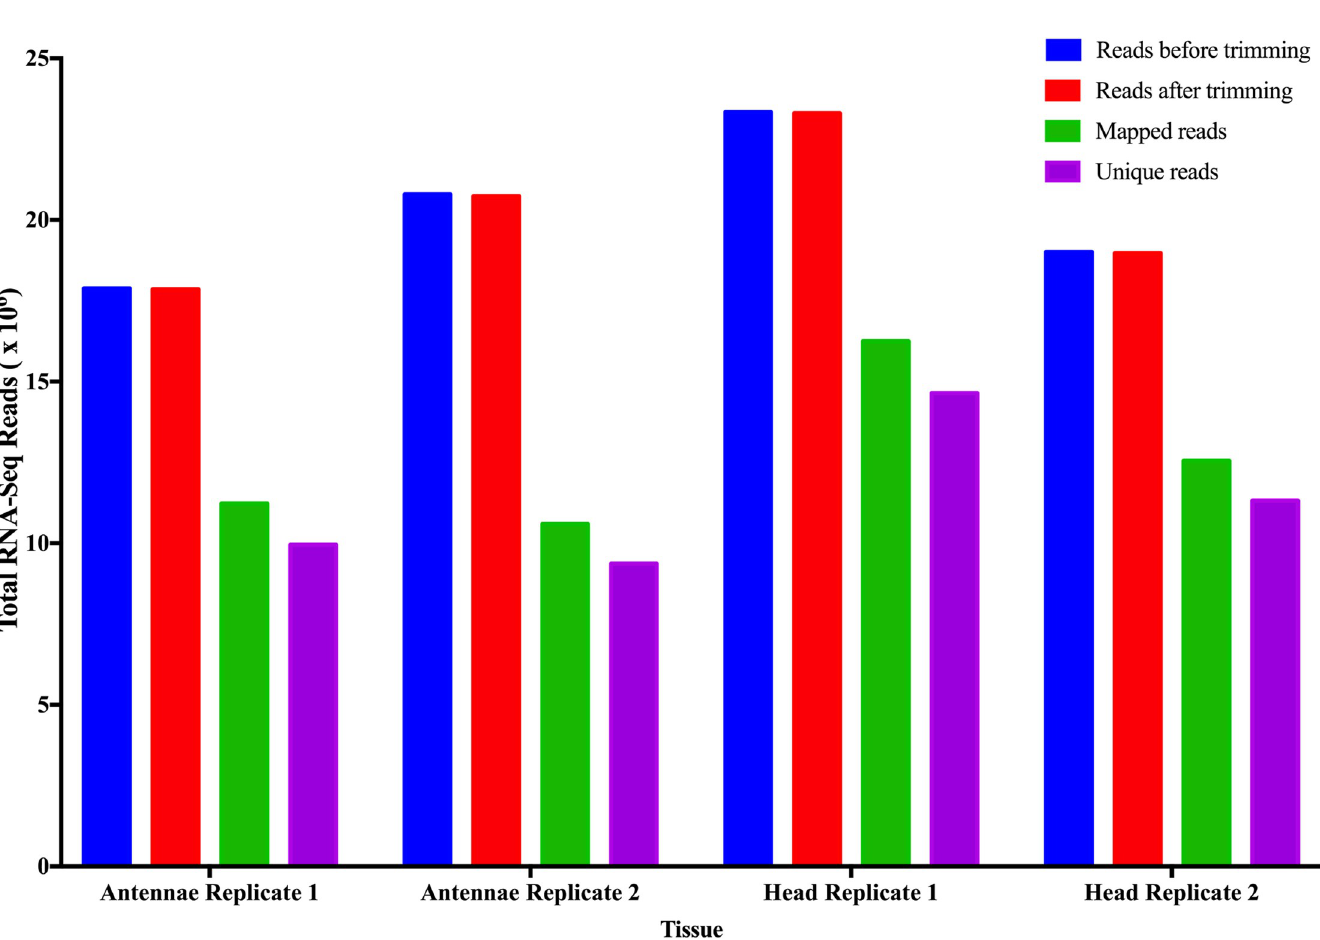
Fig 1. Summary of processing and mapping statistics of RNA-Seq reads from male G . m . morsitans antennae and head transcriptomes.